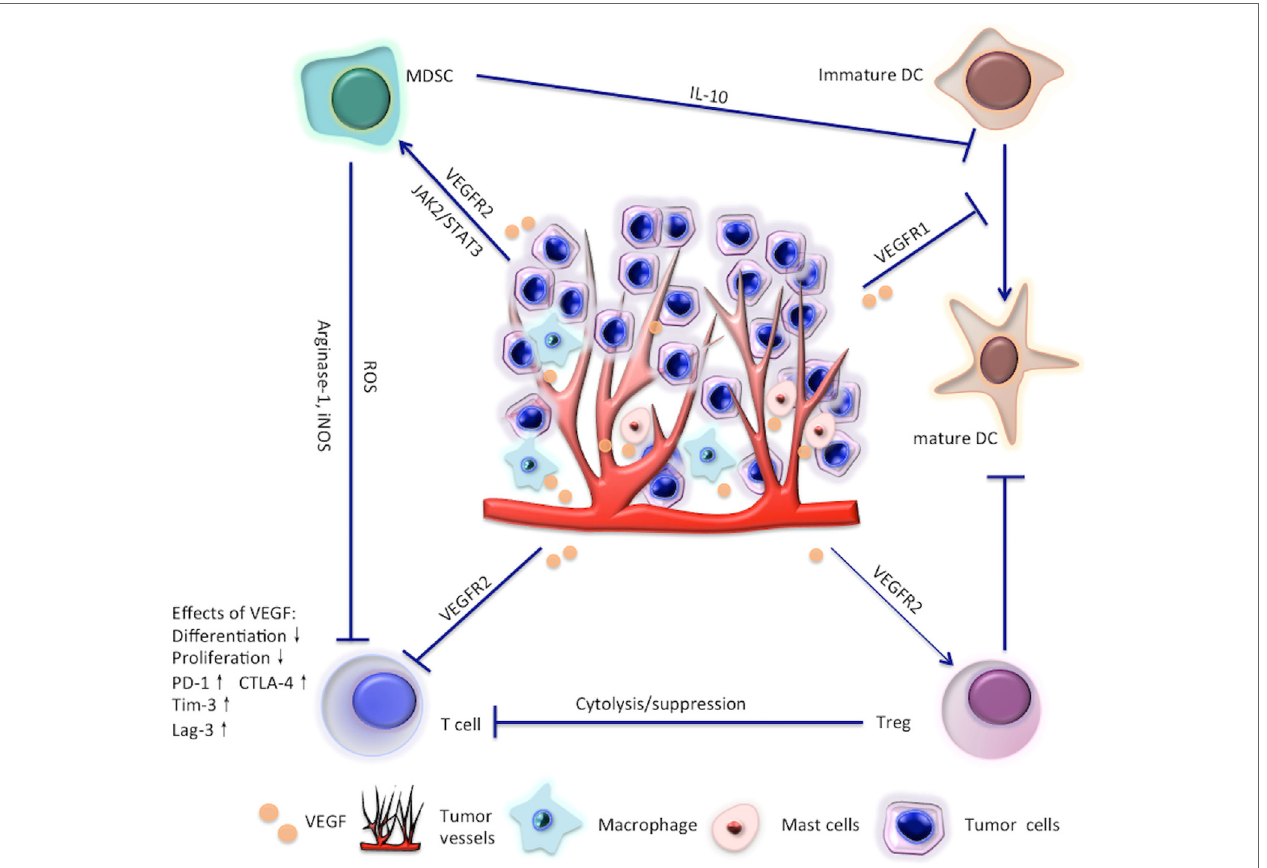
FiGURe 1 | Effects of vascular endothelial growth factor (VEGF) on T cells, regulatory T cells (Tregs), myeloid-derived suppressor cells (MDSC), and dendritic cell (DC).